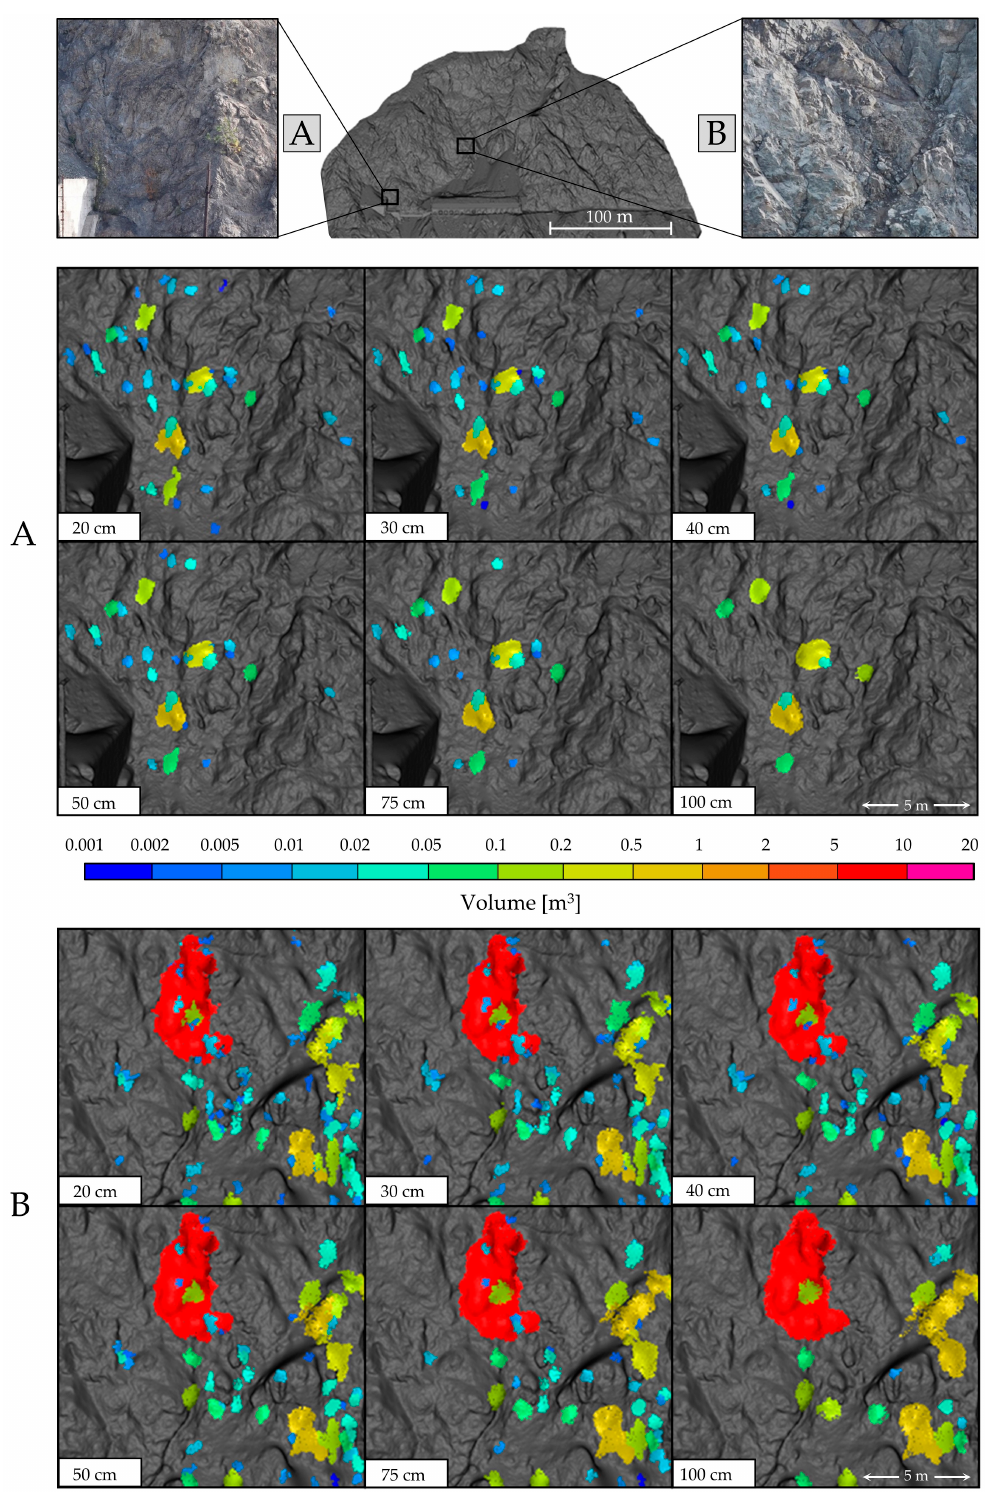
Figure 13. A depiction of the effect of spatial averaging on the rockfall inventories as a result of increasing the M3C2 projection diameter. Individual rockfall point clouds are colorized by binning their volume as shown in the color scale. Cooler colors indicate smaller volumes and warmer colors indicate larger volumes. Each cluster of a distinct color represents a single rockfall event. All change detection timesteps are plotted at once.